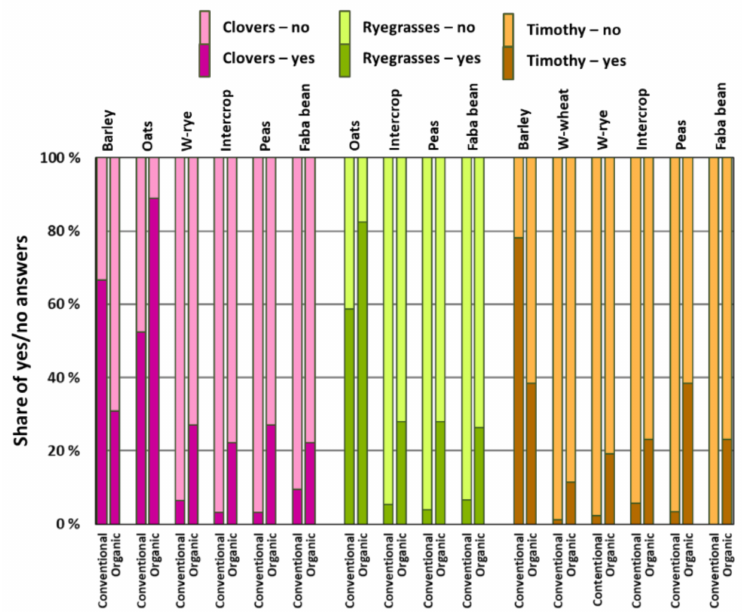
Figure 3. Impacts of the farming system on cash crop and under-sown cover crop group combinations in Finland. Only significant differences with p -value ≤ 0.05 are shown.